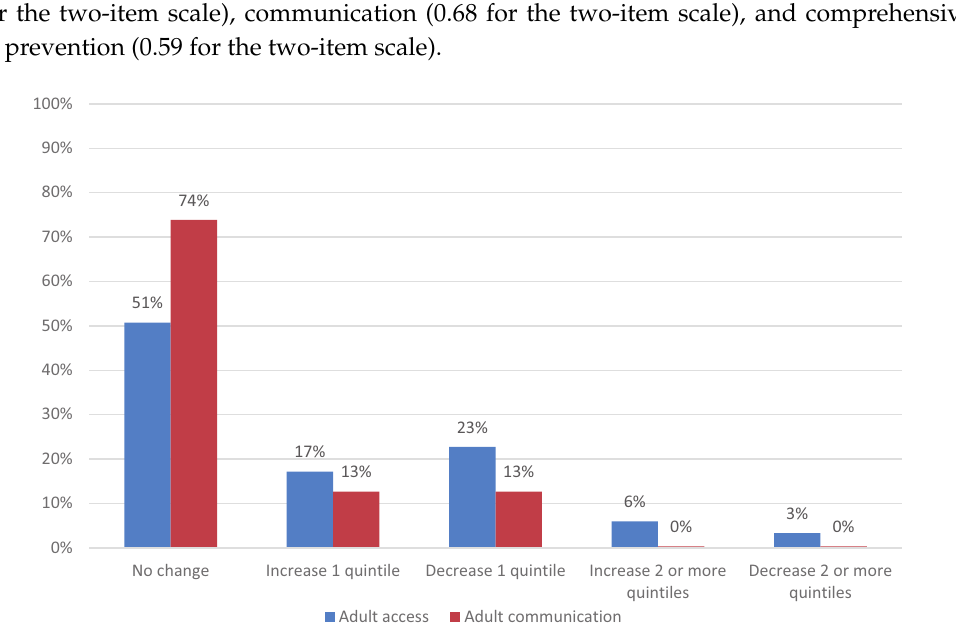
Figure 1. Change in practices’ quintile ranking from original to revised adult composites, CAHPS PCMH 2013 ( n = 268 practices).